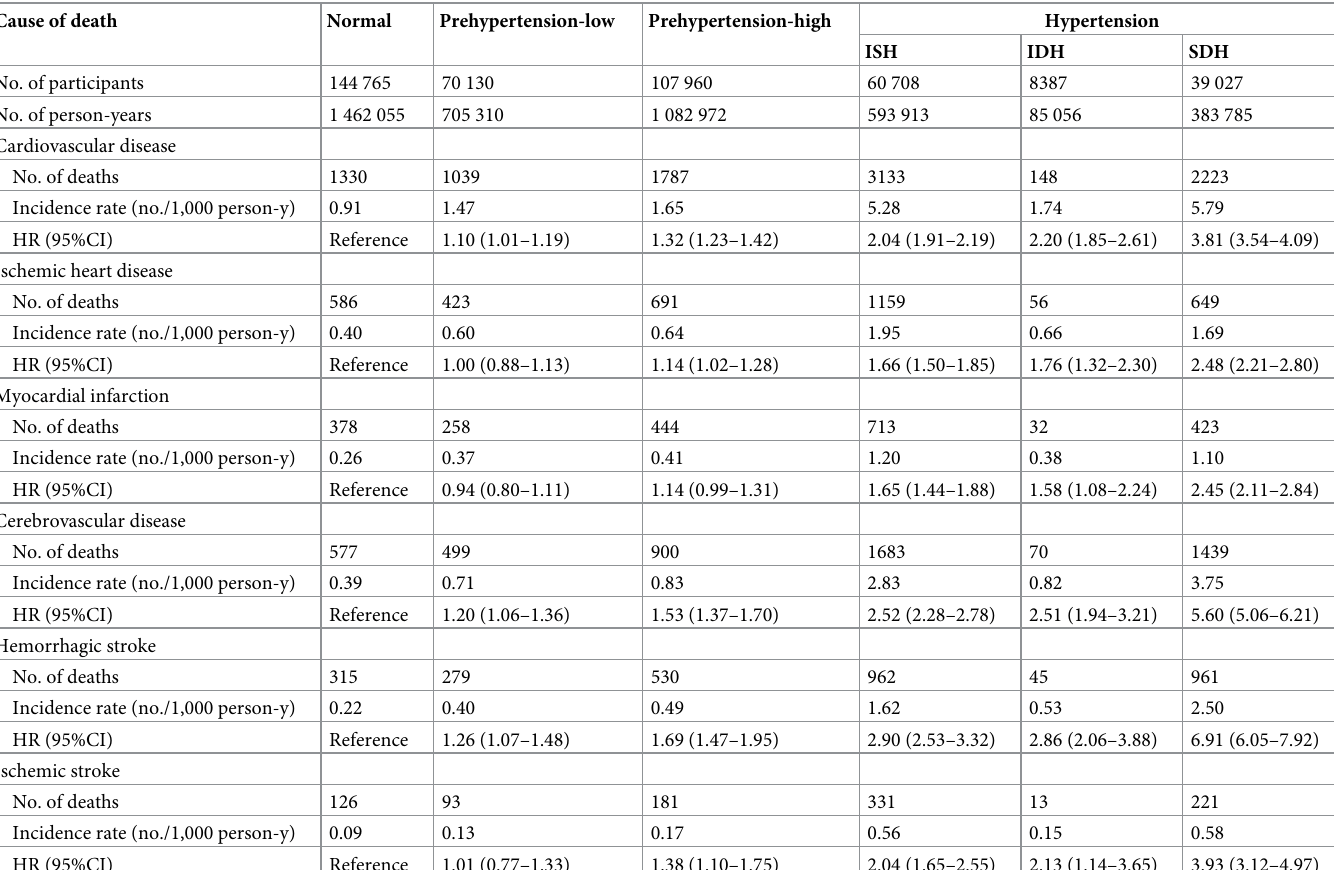
Table 2. Associations of BP categories with mortality from CVDs and its major subtypes among 430 977